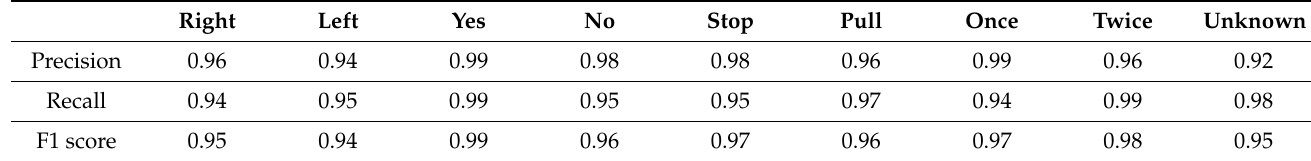
Table 5. Classification performance of each fused